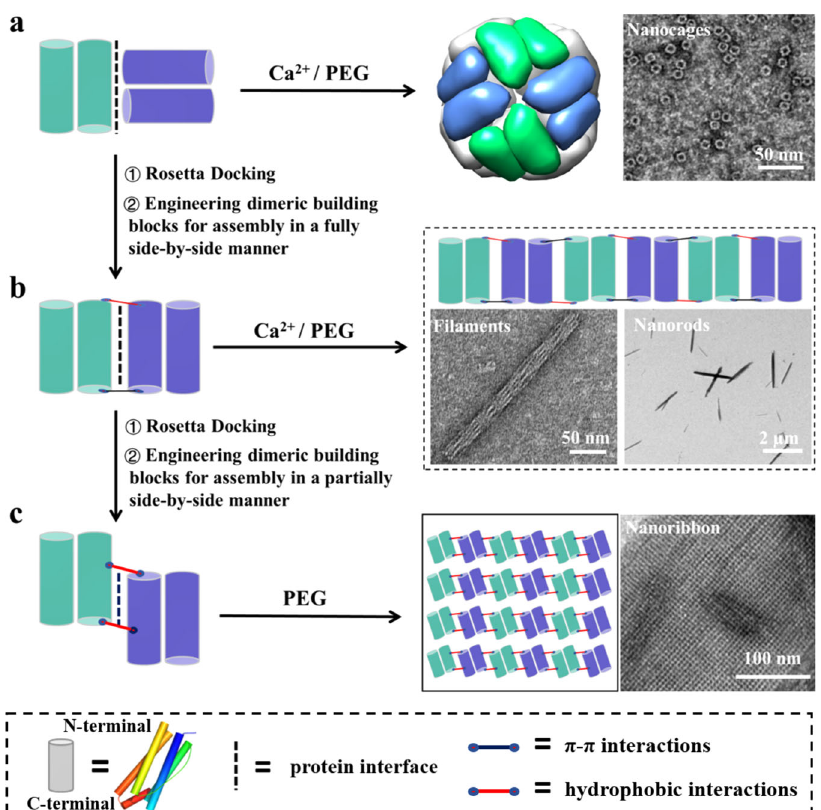
Fig. 1 Schematic representation of the protein interface redesign approach used to control the self-assembly transformation of dimeric building blocks between different types of nanomaterials. a The naturally occurring dimeric Thermotoga maritima ferritin (TmFtn) molecules interact with each other in a head-to-side manner to form 24-meric protein nanocages in the presence of calcium ions or PEG. b , c Upon Rosetta docking and designing new PPIs between adjacent dimeric building blocks in a fully or partially side-by-side manner, the assembly of similar dimeric building blocks can be transformed from the above formed hollow protein nanocages into nano fi laments or nanorods or nanoribbons in the presence of calcium ions or